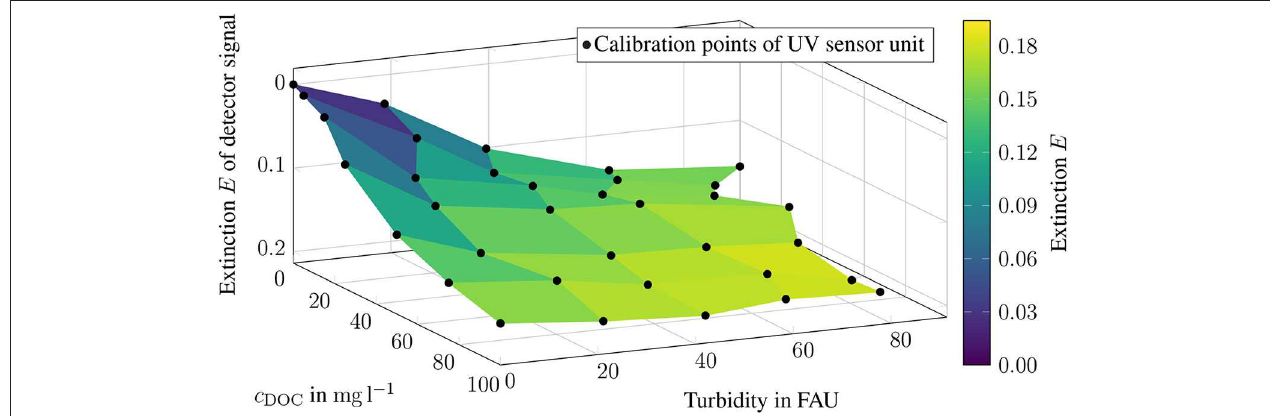
FIGURE 7 | Measured calibration points of the UV sensor represented as extinction values E , plotted on the respective DOC concentration and turbidity. The color yellow represents high detector signals, while dark blue represents low detector